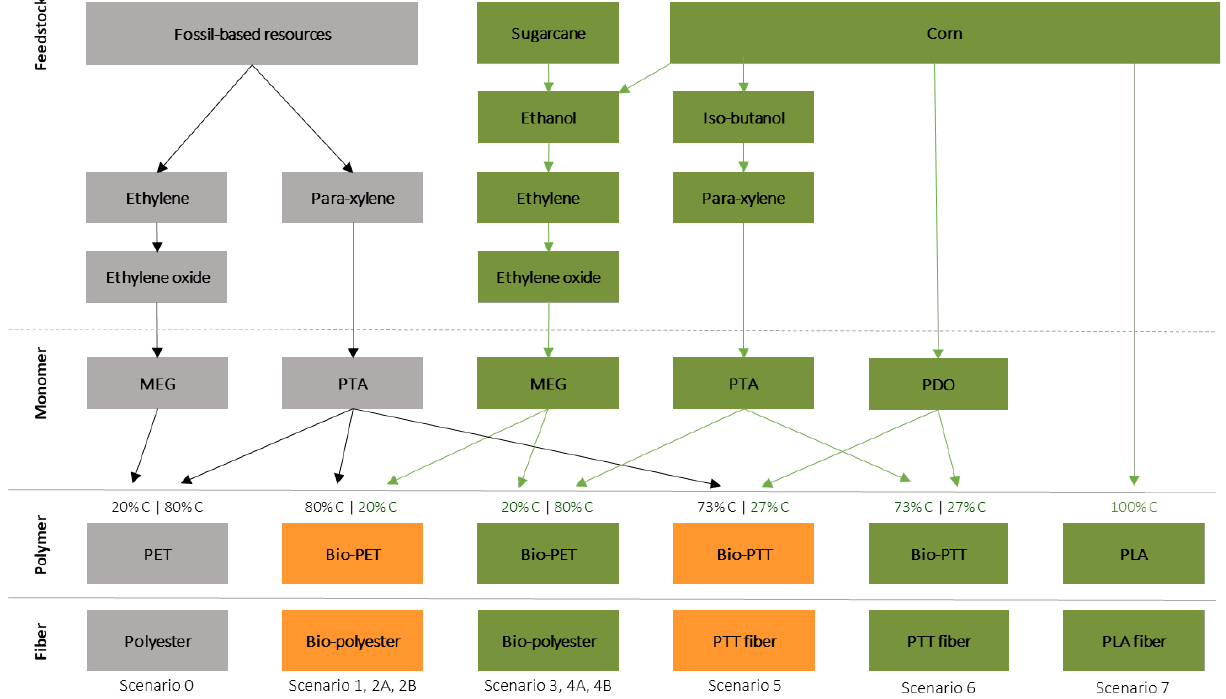
Figure 1. The production pathways of polyester and its bio-based substitutes. Polymers are transformed into fibers via melt spinning. Note that in this graph grey stands for fossil-based, green for bio-based and orange for partially bio-based products. Scenarios refer to the system setup in modeling. Scenario 1 contains corn-based monoethylene glycol (MEG); MEG in Scenario 2A and 2B stems from sugarcane, whereas the ethanol production processes differ between the two. Same explanations apply for Scenarios 3, 4A and 4B, respectively. (MEG: monoethylene glycol; PTA: purified terephthalic acid; PET: polyethylene terephthalate; PDO: 1,3-propanediol; PTT: polytrimethylene terephthalate; PLA: polylactic acid).) Table 1. Feedstock requirements for each scenario. Note that these results are independent of the impact assessment applied.